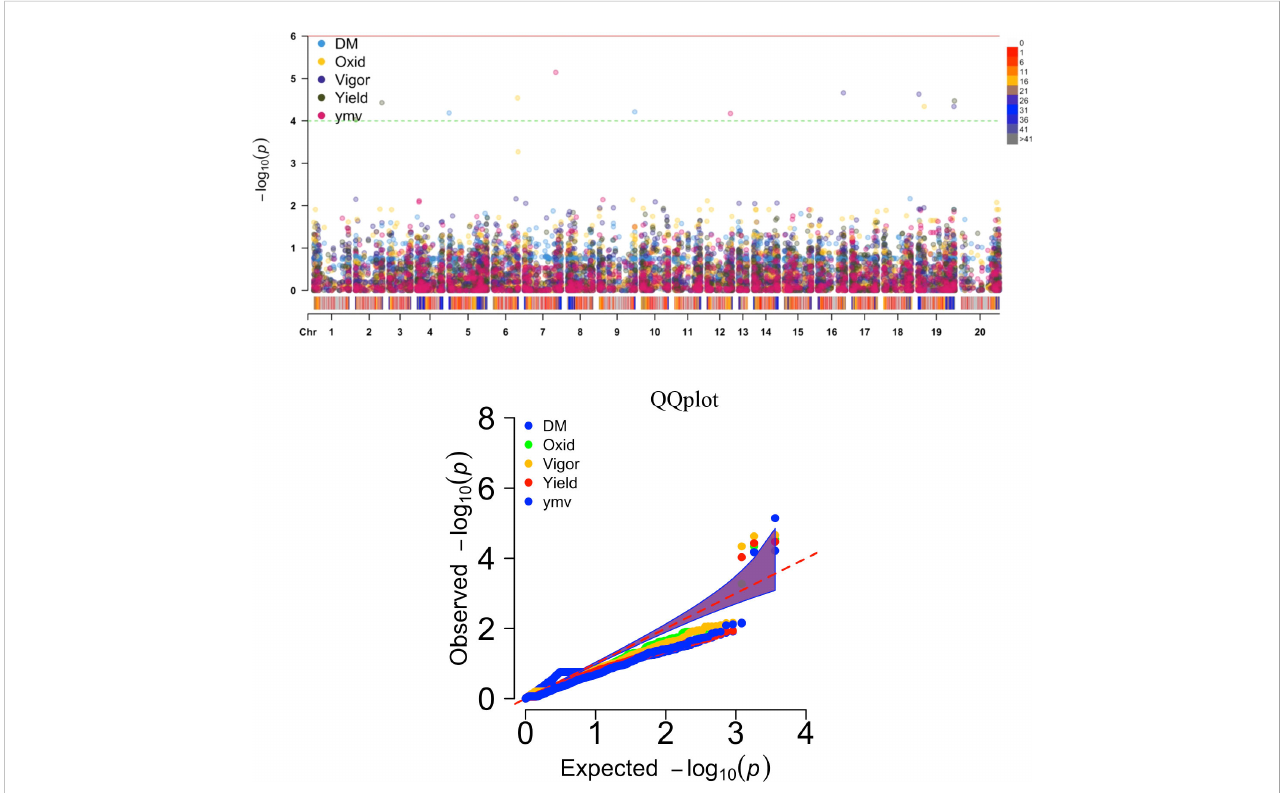
FIGURE 4 Manhattan and QQ plots displaying regions of genome signi fi cantly associated with natural variation for fi ve traits targeted in this study using the K+Q model. DM, dry matter (%); Oxid, tuber fl esh oxidation (scale); Vigor, plant vigor (scale); Yield, tuber yield (t ha-1); ymv, yam mosaic virus severity (AUDPC